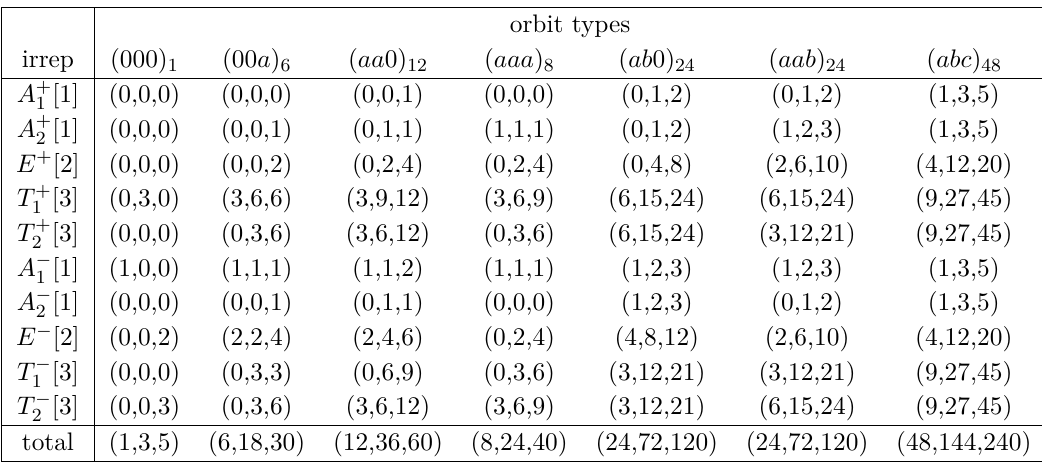
Table 10. Dimension of irrep projection sub-blocks for each orbit type and angular momentum, ( d ( P ) , d ( P )) , for the frame with d = (0 , 0 , 0) . Each row corresponds to an , d ( P ref I,o (0)) I,o (1) I,o (2) irrep of the cubic group O , whose dimension is listed in square parentheses. Entries assume h particles are pseudoscalars; for scalars irreps should be interchanged with their parity counterparts. See table 4 for orbit-type compositions. The bottom row gives the sum of the rows above, which equals d (2 ‘ +1) , where d is the number of elements in the orbit, which is given as a subscript orbit orbit for each orbit type.